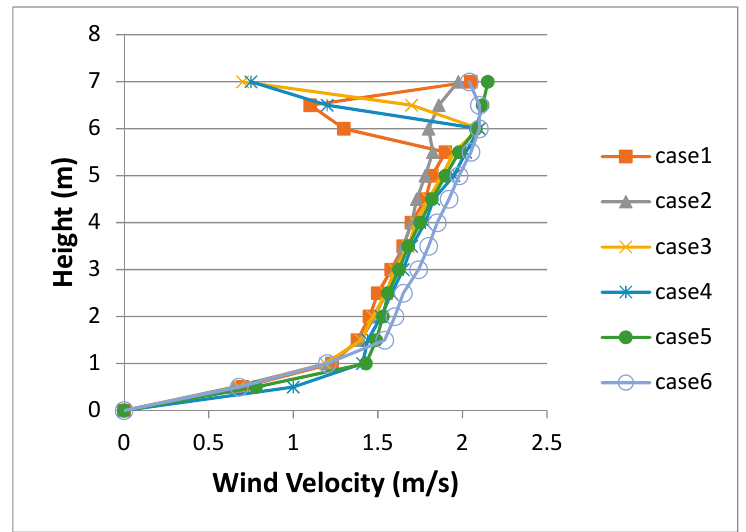
Figure 10. Simulated mean wind velocities located at the 7 m height vertical line centre alley. Table 5. Simulated mean wind velocity outcomes for each case along the 7 m vertical profile.